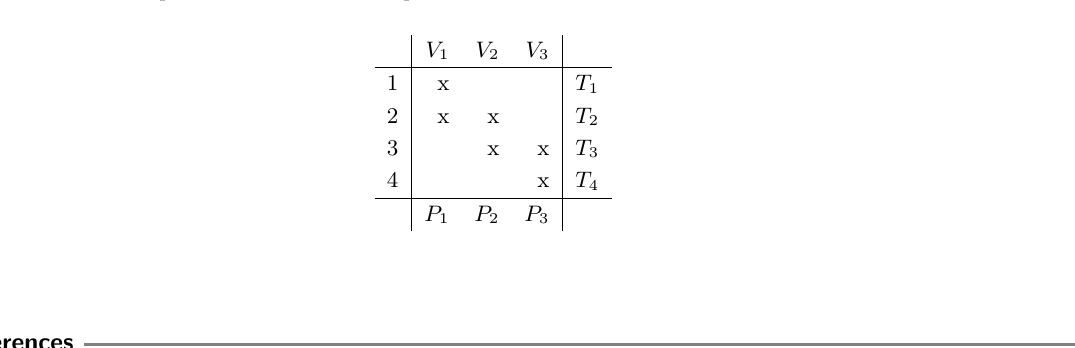
Table 2 Example construction for the proof of Theorem